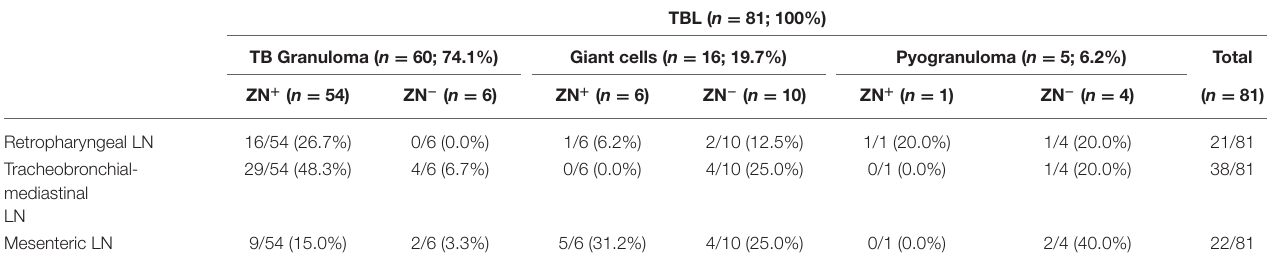
TABLE 4 | Relationship between microscopic lesions and the presence of acid-fast bacilli (AFB) in different lymph nodes. TBL ( n = 81; 100%) TB Granuloma ( n = 60; 74.1%) Giant cells ( n = 16; 19.7%) Pyogranuloma ( n = 5; 6.2%) Total ZN + ( n = 54) ZN − ( n = 6) ZN + ( n = 6) ZN − ( n =